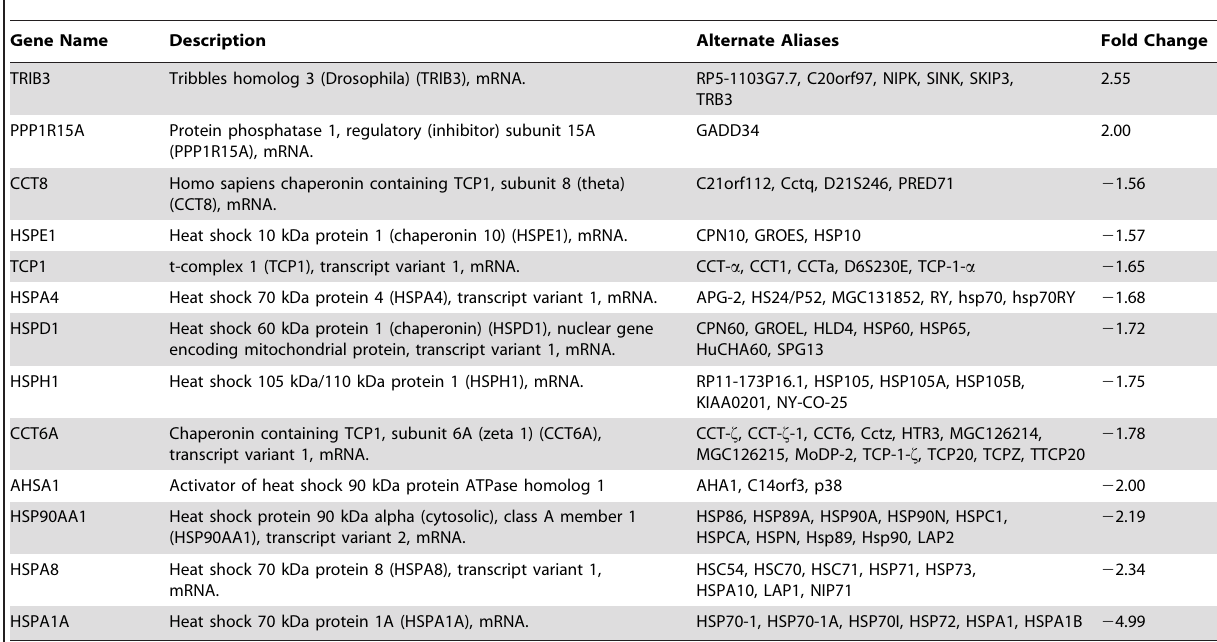
Table 1. Molecular Chaperone and Stress Response Genes Regulated by Everolimus.